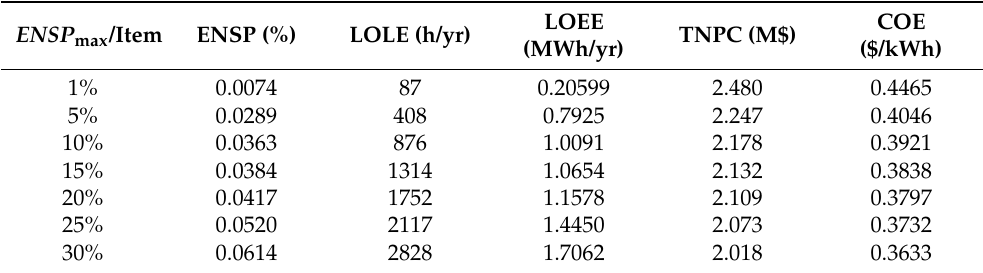
Table 9. Reliability and cost results in sizing HPV/FC energy systems using the IAEO, considering different ENSP max .